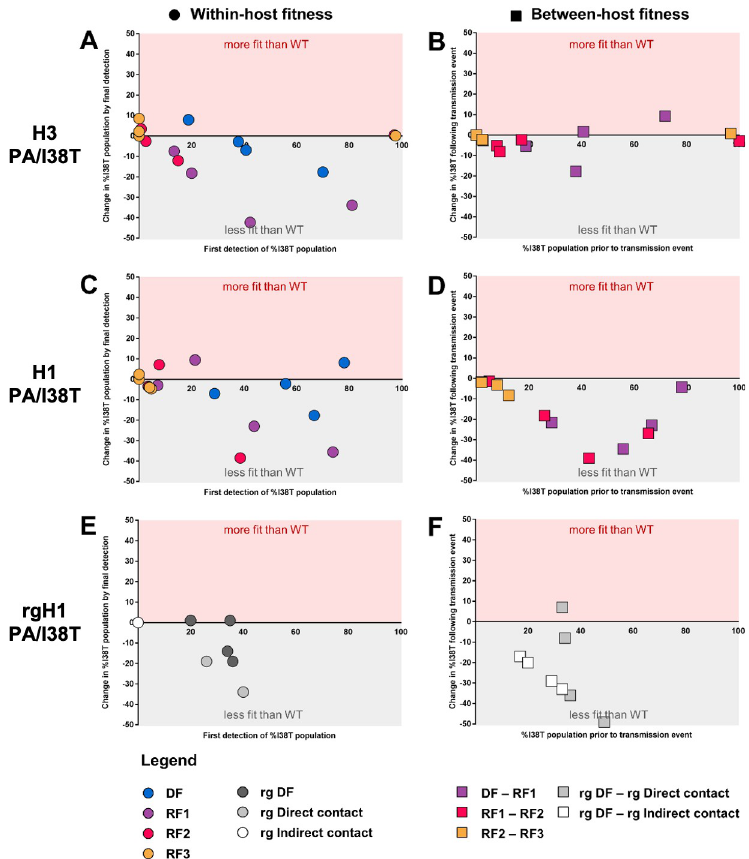
Fig 5. Visualisations of estimated within-host fitness and between-host fitness for PA/I38T-variant viruses. Within-host, and between-host transmission fitness visualisation for PA/I38T-substituted clinical isolates (A–D) and recombinant viruses (E and F). (A, C and E) Within-host fitness graph Y-axis plots the change in %I38T population from first valid pyrosequencing/NGS detection (on X-axis) compared to last detection in each individual ferret (coloured circles represent DF: blue; RF1: purple; RF2: pink; RF3; yellow; rg DF: charcoal; rg direct contact: grey; rg indirect contact: white). Points in red shaded area indicate %I38T increased over time, grey shaded area indicates % I38T reduced over time. (B, D and F) Between-host fitness graph Y-axis plots the change in %I38T population for each transmission event measured using the first valid pyrosequencing/NGS measurement of %I38T in the recipient compared to the %I38T in the respective donor on the previous day (donor value is the X-axis). Coloured squares represent generations of transmission (1st, DF-RF1: purple; 2nd, RF1-RF2: pink; 3rd, RF2-RF3: yellow) or route of transmission (grey: direct contact; white: indirect contact). Points in red shaded area indicate %I38T increased following transmission, grey shaded area indicates %I38T reduced following transmission. DF, donor ferret, NGS, next generation sequencing; RF, recipient